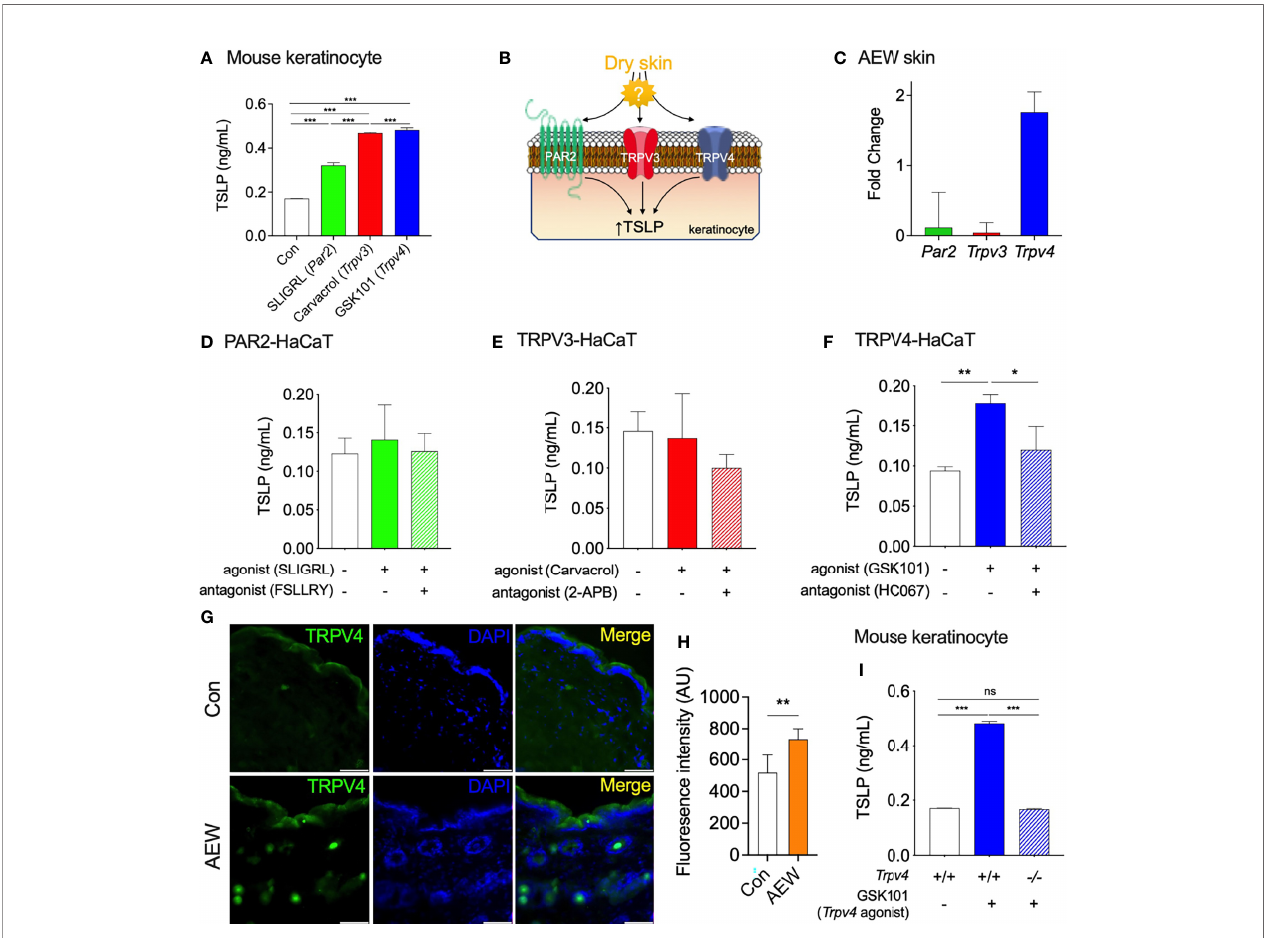
FIGURE 2 | TRPV4 partakes in the elevated production of TSLP in dry skin conditions. (A) The production of TSLP in the murine keratinocytes was increased by SLIGRL (50 µM, a PAR2 agonist), carvacrol (100 µM, a TRPV3 agonist), and GSK101 (10 µM, a TRPV4 agonist). (B) A schematic illustration of the putative relationship between the elevated production of TSLP and proteins-of-interest (PAR2, TRPV3, and TRPV4) in dry skin conditions. (C) The transcriptional levels of Trpv4 increased in the keratinocytes of AEW-treated mice, whereas those of Par2 and Trpv3 remained unaltered (n = 3). (D) The activation of PAR2 expressed in HaCaT cells did not alter the production of TSLP. PAR2 was activated by 50 µM SLIGRL (n = 3) and inhibited by 10 µM FSLLRY (n = 3). (E) The activation of TRPV3 expressed in HaCaT cells did not alter the production of TSLP. TRPV3 was activated by 100 µM carvacrol (n = 3) and inhibited by 100 µM of 2-APB (n = 3). (F) The activation of TRPV4 expressed in HaCaT cells induced the production of TSLP. TRPV4 was activated by 10 µM GSK101 (n = 3) and inhibited by 100 µM HC067047 (HC067; n = 3). (G) The immunostaining of TRPV4 in the skin tissues of AEW-treated mice revealed that the fl uorescence intensity was higher than that of the control ( H ; AU: arbitrary unit). The scale bar indicates 50 µm. (I) The production of TSLP signi fi cantly increased in the keratinocytes of Trpv4 +/+ mice following treatment with 10 µM GSK101. However, the levels of TSLP in the keratinocytes of Trpv4 -/- mice remained unaltered even after treatment with 10 µM GSK101. * p < 0.05, ** p < 0.01, *** p < 0.001, n.s. not signi fi